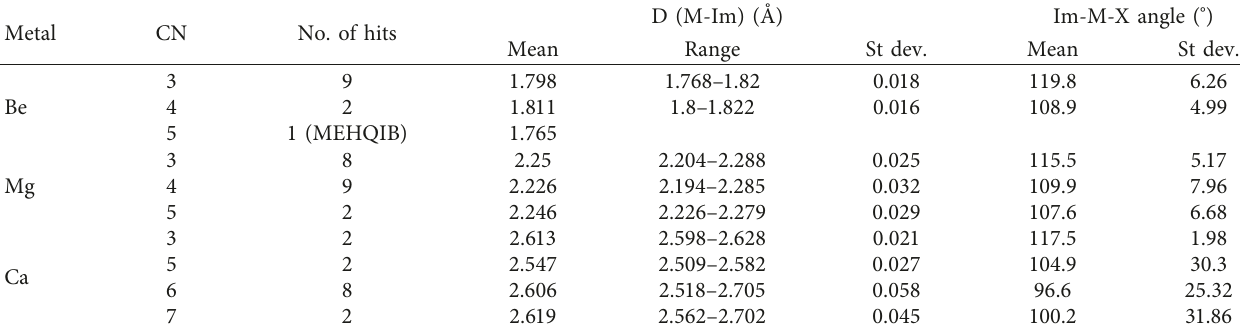
Table 2: The number of entries (hits), coordination number (CN), and bond parameters of group IIA metal-imidazol-2-ylidenes. Metal